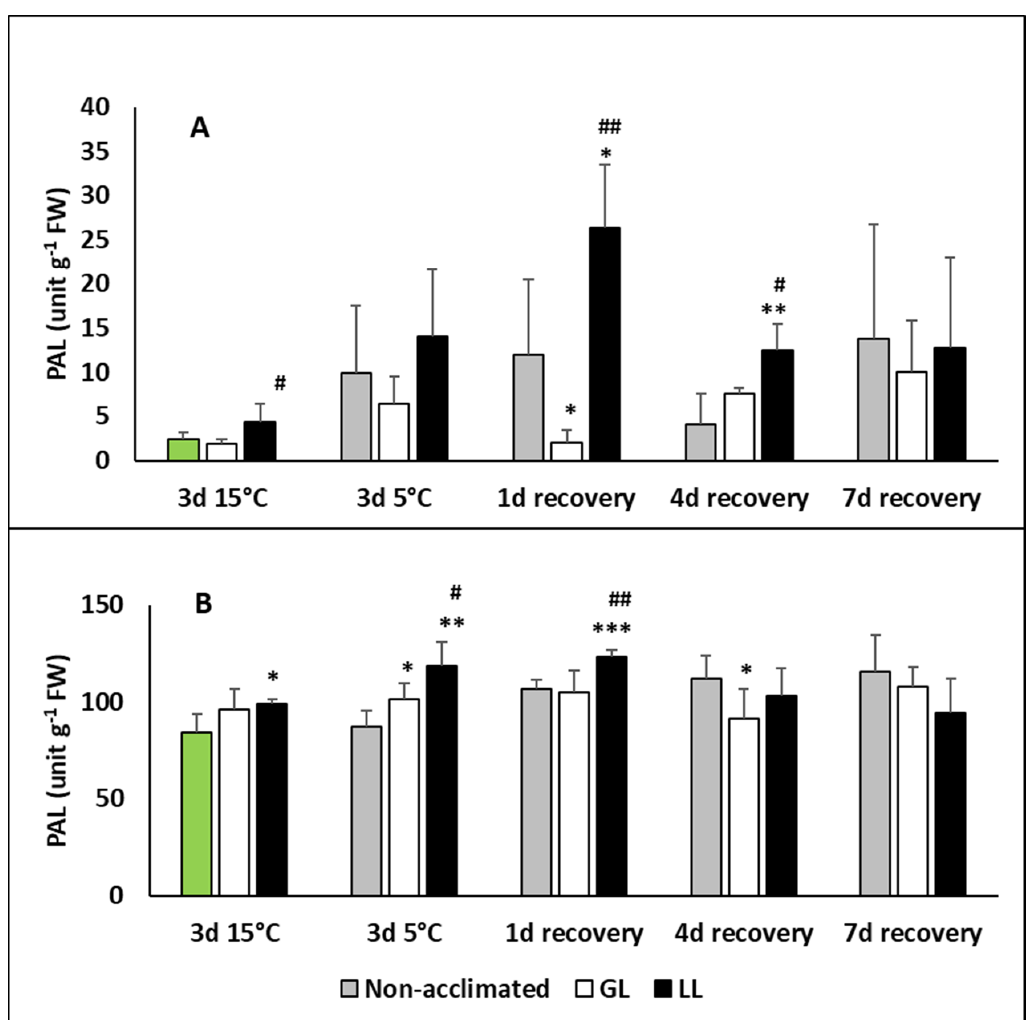
Figure 7. Changes in the phenylalanine ammonia lyase (PAL) contents during cold acclimation (15/13 °C), chilling (5 °C) and recovery in the leaves and roots of young maize plans: control plants (22/20 °C, 387 µmol m −2 s −1 ). Light intensities during hardening: GL: 387 µmol m −2 s −1 ; LL: 107 µmol m −2 s −1 . (22 / 20 ◦ C, 387 µ mol m − 2 s − 1 ). Light intensities during hardening: GL: 387 µ mol m − 2 s − 1 ; LL: 107 µ mol m − 2 s − 1 . *, **, *** significant di ff erences compared to the control plants on the same day at